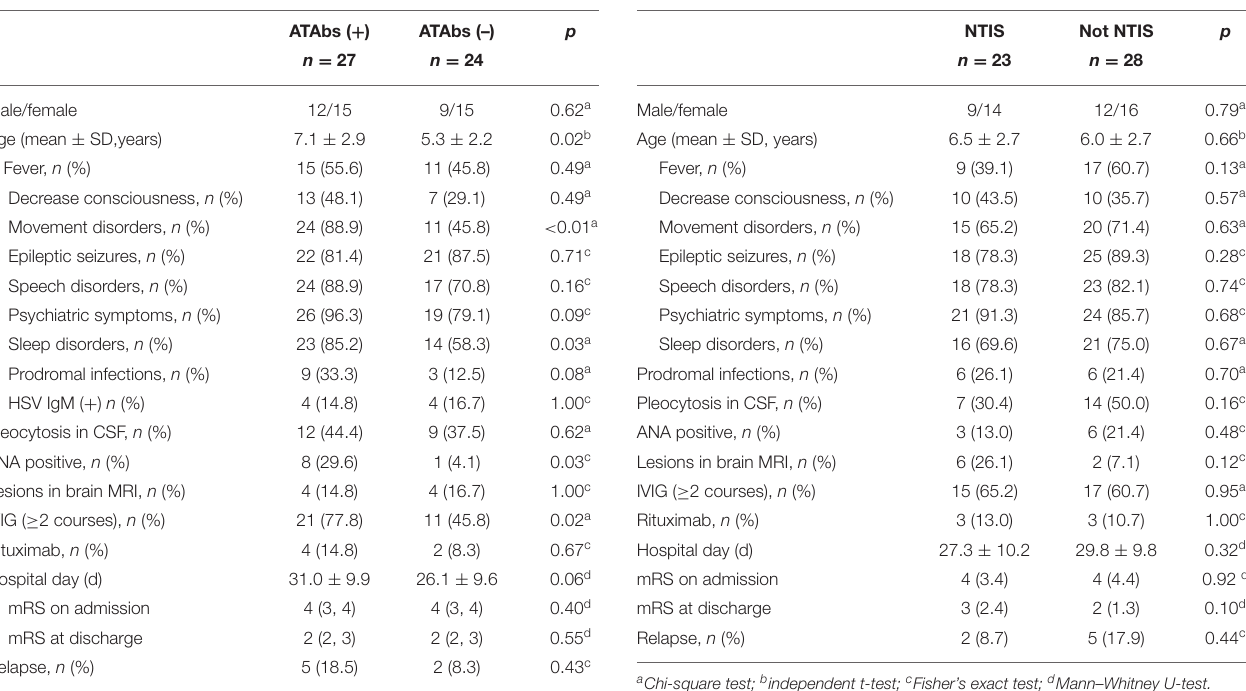
TABLE 2 | Comparison of clinical characteristics between the ATAb ( + ) and ATAb (–) groups.